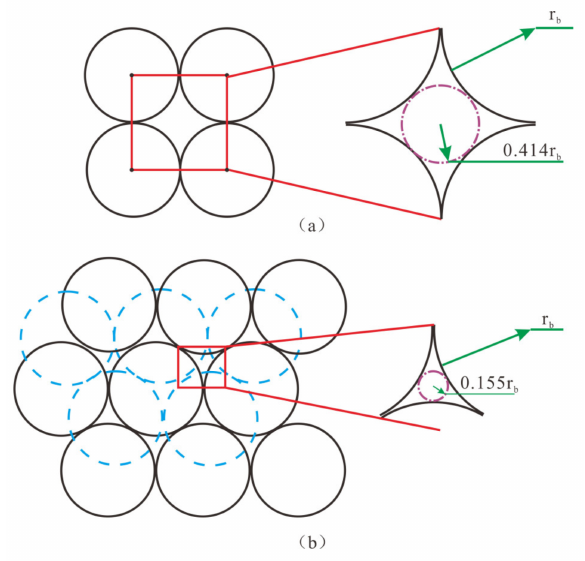
Figure 3. The porous medium formed by first-stage bridging. ( a ) Cubic loose pack; ( b ) Face-centered cubic or hexagonal close